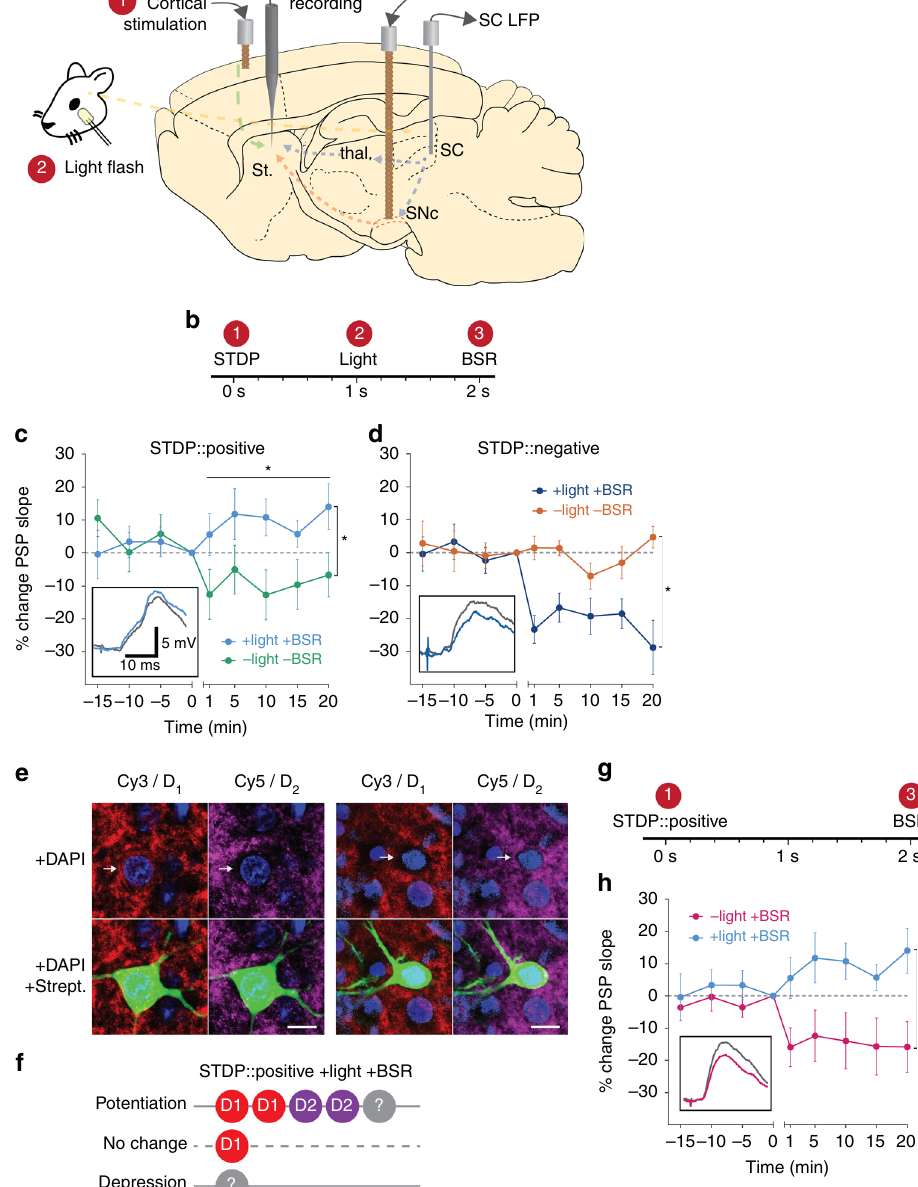
Fig. 2 Reinforcement modulates corticostriatal STDP to enable bidirectional plasticity. a Schematic view of stimulating and recording sites. Numbers in red relate to components of the experimental protocol b . c Positive STDP pairings are modulated by the reward components ( blue , n = 7) to induce lasting potentiation of corticostriatal synapses (time points after protocol vs. baseline, LME, est. effect size = 8.8 ± 3.3%, F 1,46 = 6.69, P = 0.013), which was signi fi cantly different from positive pairings without reinforcement (LME, est. effect size = 20.1 ± 8.8%, F 1,11 = 5.20, P = 0.043). Inset shows representative PSPs as de fi ned in Fig. 1(f). d Negative STDP pairings are modulated by the reward components ( dark blue , n = 5) to induce lasting depression of corticostriatal synapses, signi fi cantly different from negative pairings without reinforcement (LME, est. effect size = 24.5 ± 8.3%, F 1,10 = 10.40, P = 0.009). e Examples of D 1 (Cy3) and D 2 (Cy5) positive SPNs intracellularly fi lled with biocytin and visualized with DyLight 488-conjugated streptavidin. Note the presence of double labeling indicated by a perisomal ring within the cell membrane. Scale bar = 10 μ m. f Summary dopamine receptor results for the positive STDP pairings with reinforcement group, indicating a mixed receptor expression in cells that potentiated. g Modi fi ed plasticity protocol without the light fl ash. h Positive STDP pairings, when modulated by BSR alone at 2 s ( pink , n = 5), induce long-lasting depression, signi fi cantly different from positive pairings with light and BSR (LME, est. effect size = 24.4 ± 9.6%, F 1,10 = 6.40, P = 0.029). Data presented as mean ±